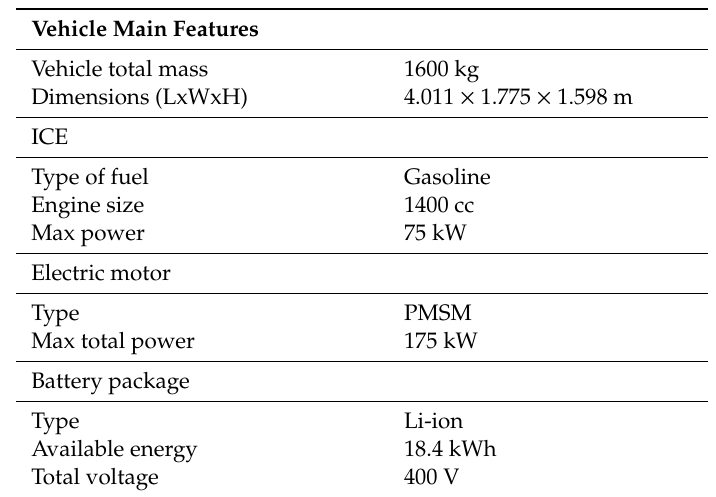
Table 26. Chevrolet Volt main data.